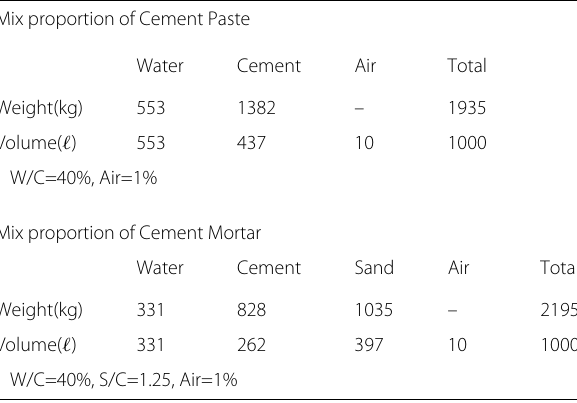
Table 1 Mix proportion of the test pieces Mix proportion of Cement